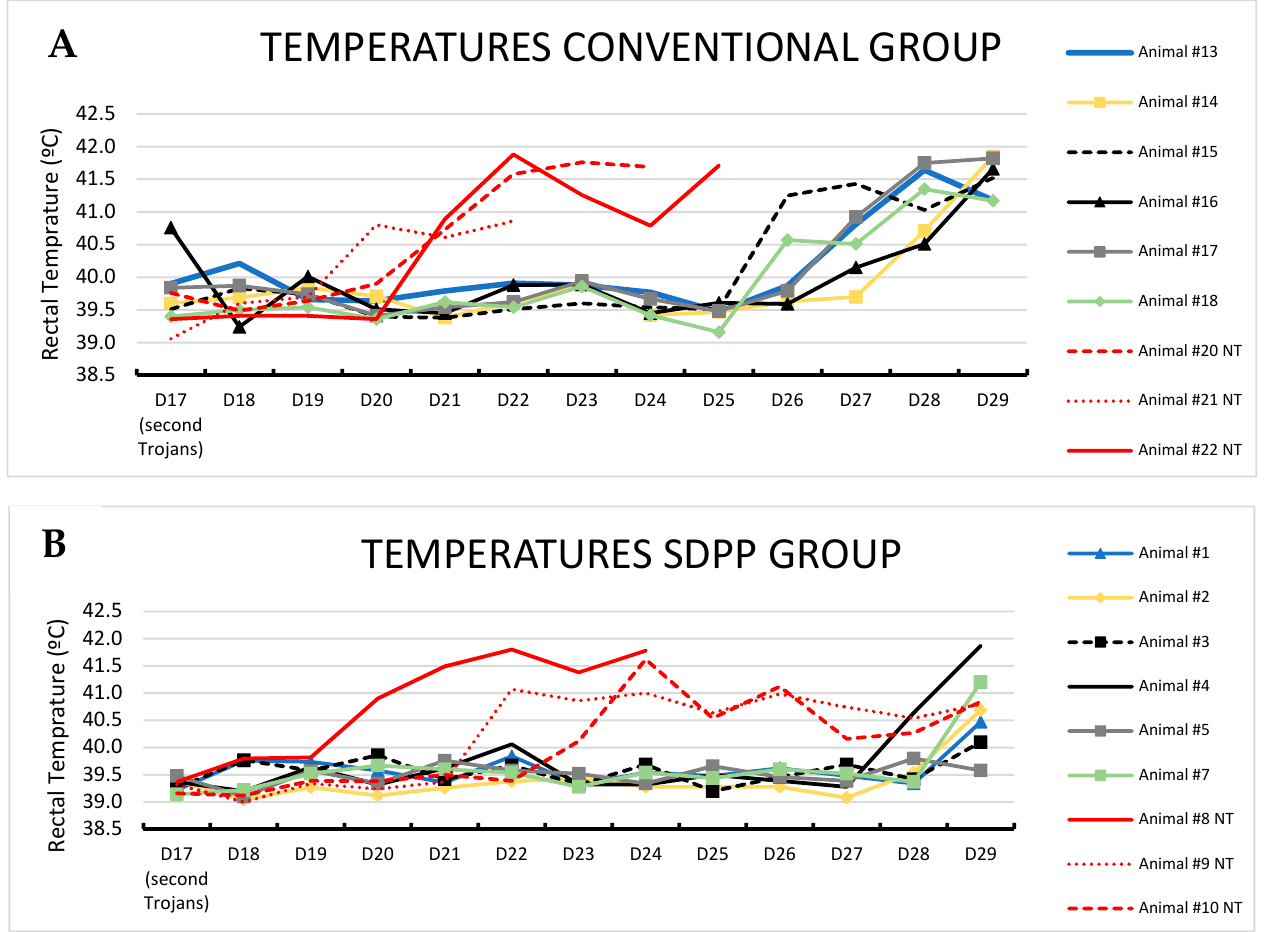
Figure 2. Rectal temperature over time after second ASFV exposure. ( A ): animals fed with CONVENTIONAL diet and ( B ): animals fed with spray dried porcine plasma (SDPP) diet. In red color are the trojans animals in each group.